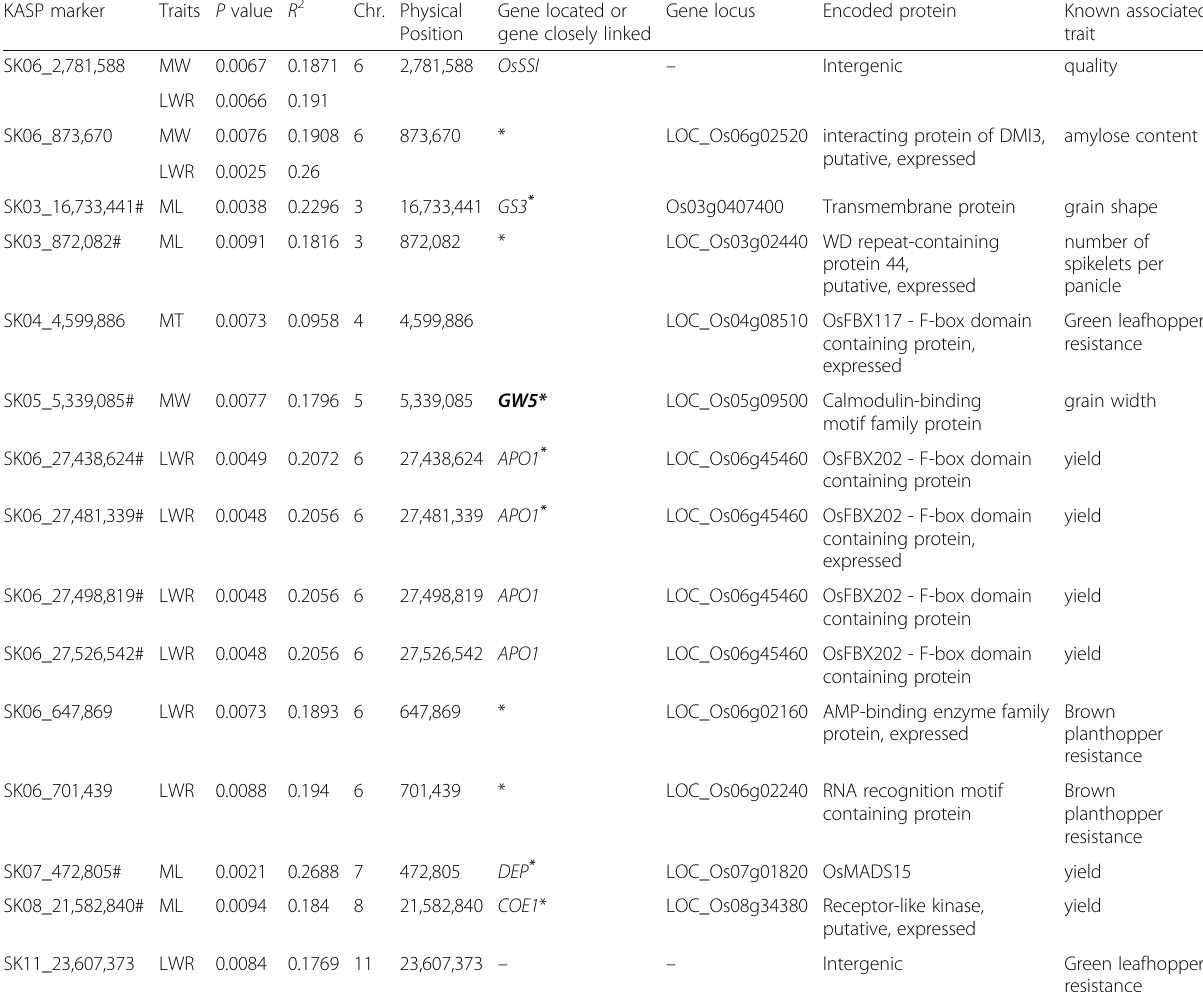
Table 6 Associations between KASP markers and phenotypes (Continued) KASP marker Traits P value R 2 Chr. Physical